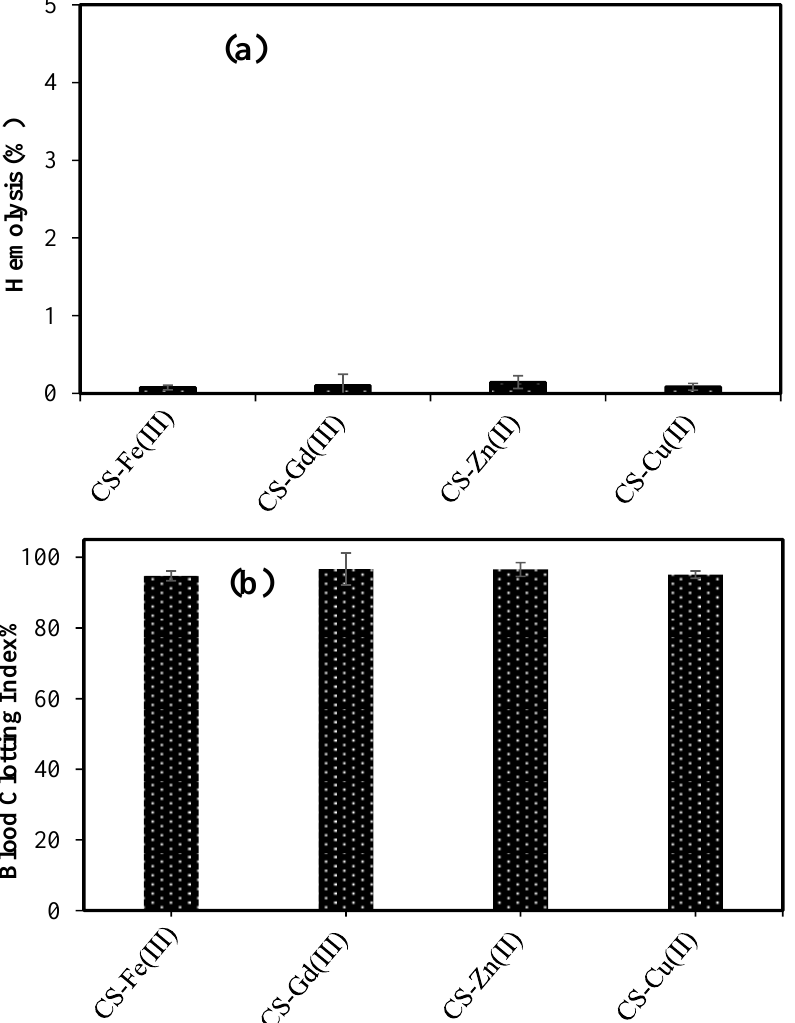
Figure 4. ( a ) Hemolysis ratio and ( b ) blood clotting index of CS-Fe(III), CS-Gd(III), CS-Zn(II), and CS-Cu(II) particles at 1 mg/mL concentration.